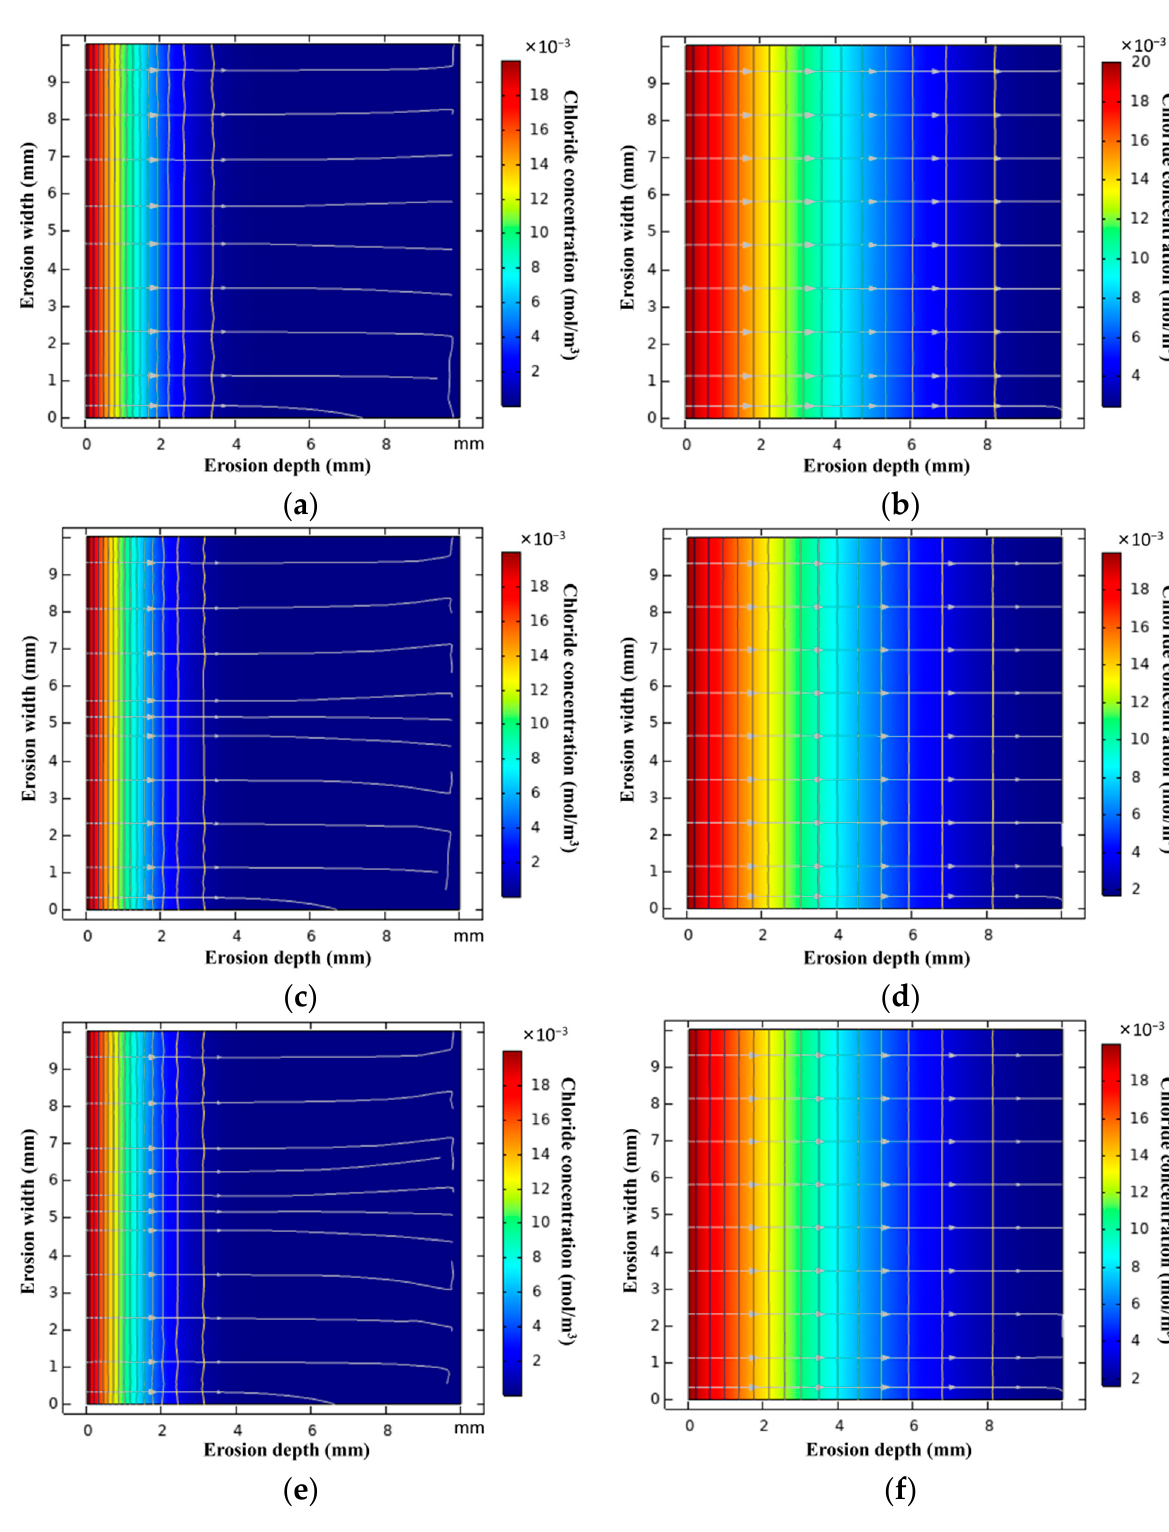
Figure 5. ( a ) 0.15–4.75 mm–30 d; ( b ) 0.15–4.75 mm–360 d; ( c ) 0.15–2.36 mm–30 d; ( d ) 0.15–2.36 mm–360 d; ( e ) 0.15–1.18 mm–30 d; ( f ) 0.15–1.18 mm–360 d.